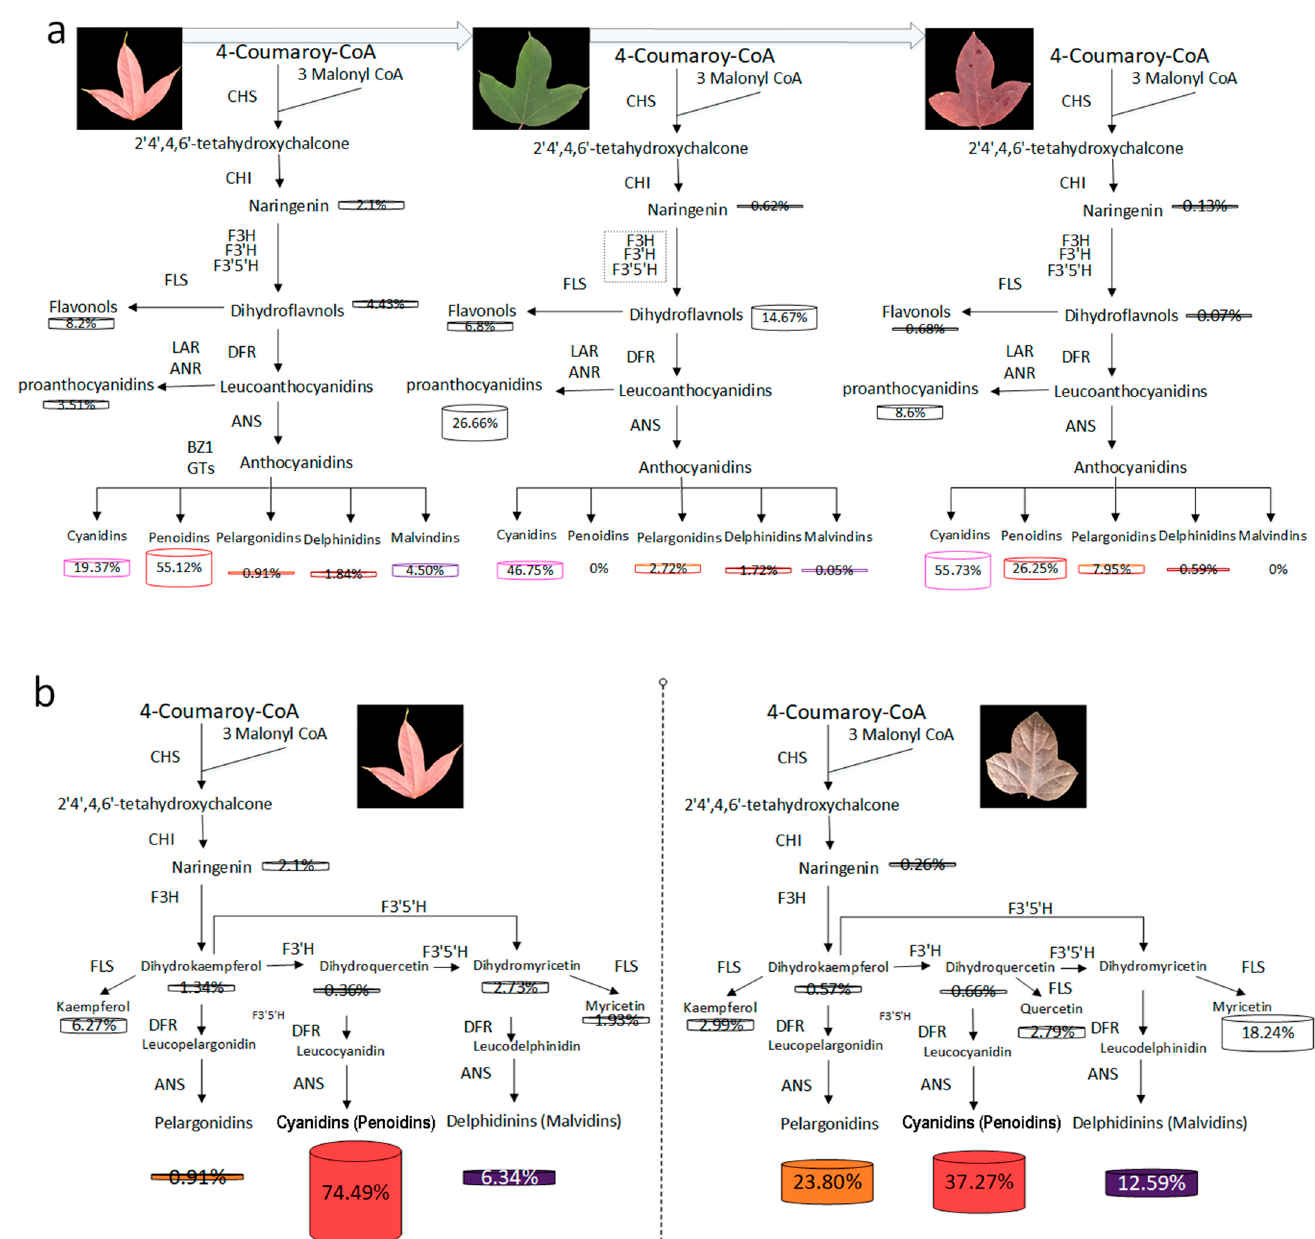
Figure 6. The models for anthocyanins biosynthesis in three season leaves of NLH ( a ), and processing in spring leaves of NLH and ZF ( b ), respectively. The abbreviations of the enzymes can be found in Supplementary Table S5.